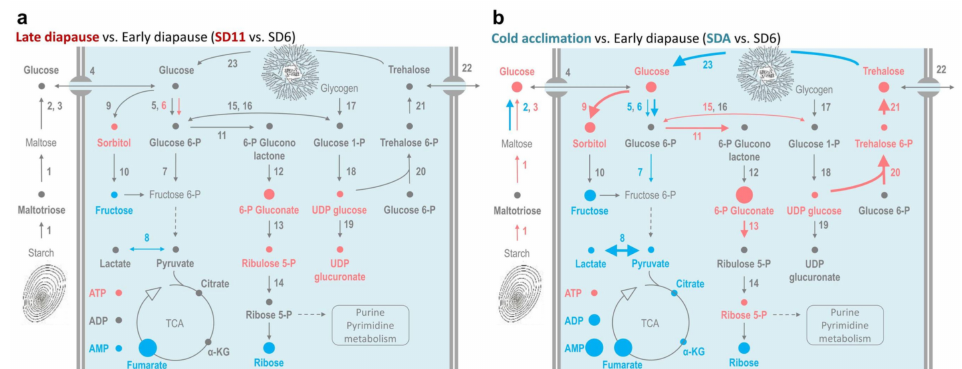
Figure 4. Changes in metabolism of trehalose during diapause maintenance vs. cold acclimation in C. costata larvae. The maps show log 2 -fold changes in relative concentrations of metabolites (circles) and gene expressions (arrows) during diapause maintenance ( a ) and gradual cold acclimation ( b ) (see Table S5). Other descriptions are as in Figure 2. TCA, tricarboxylic acid cycle; α -KG,